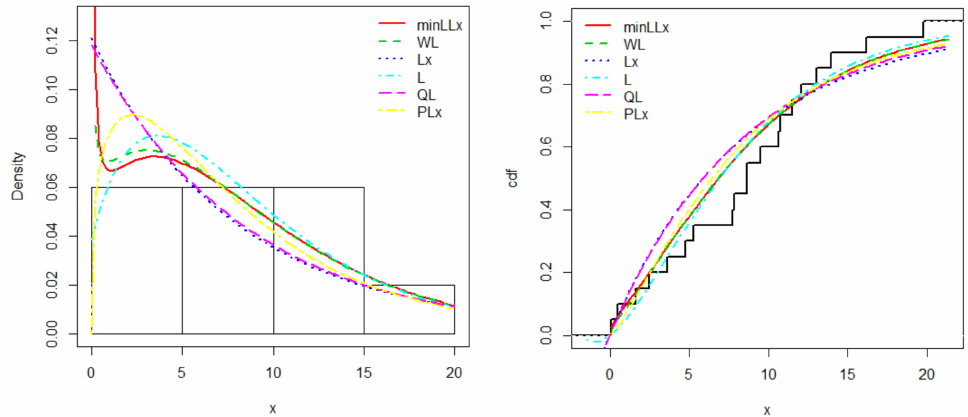
Figure 4. Estimated pdf and cdf plots of the minLLx distribution for the second data